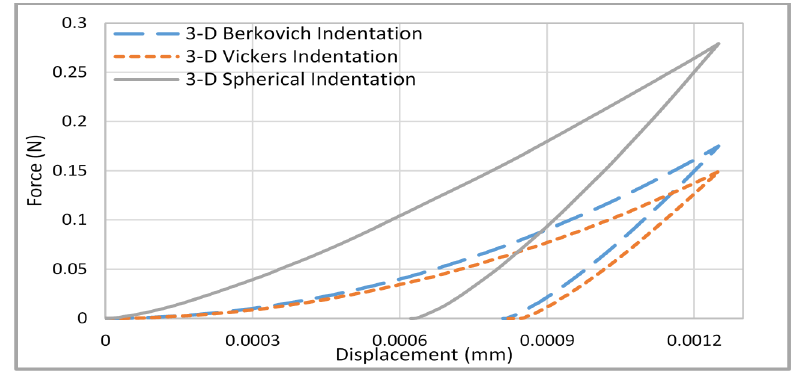
Figure 9. Target Drucker–Prager numerical load displacement curves determined from 3-D finite element modelling (FEM) simulations for ( a ) Berkovich, ( b ) Vickers and ( c ) spherical indentations.